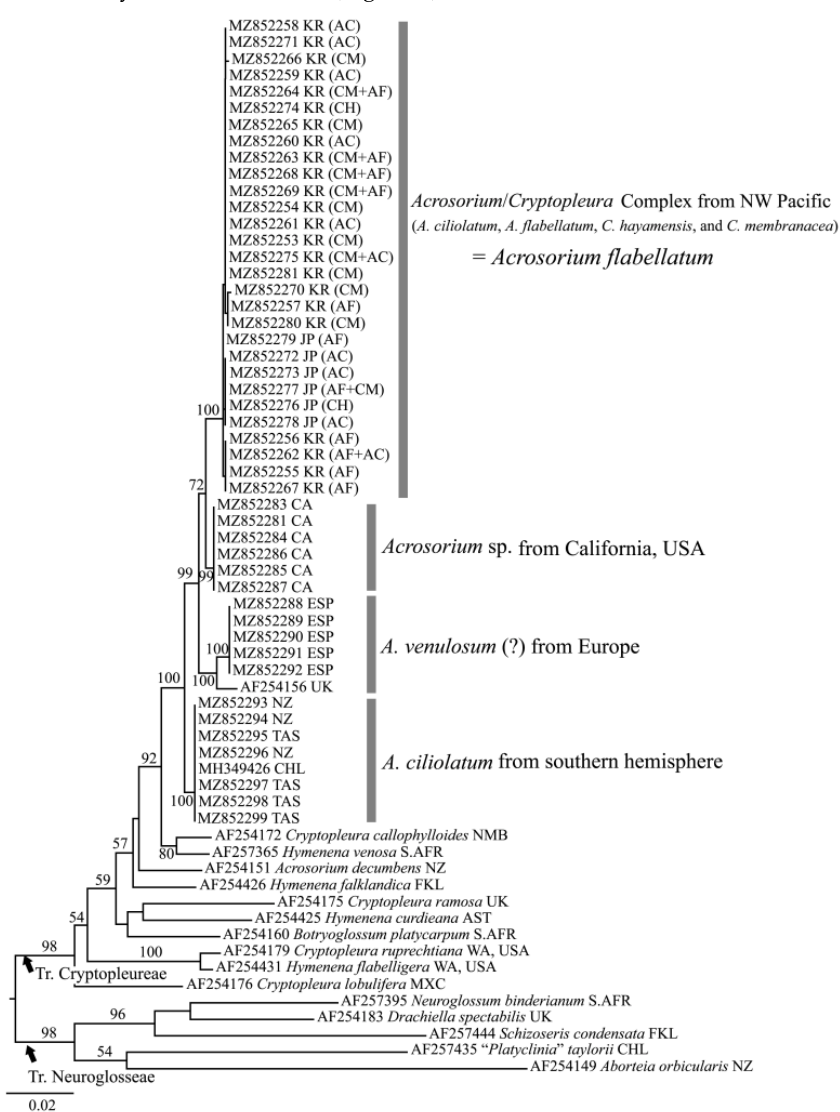
(Figure 3L)—and the overlapping phenotypes (Figure 3C,F–H) were all in the same clade without any distinct structure (Figure 2).